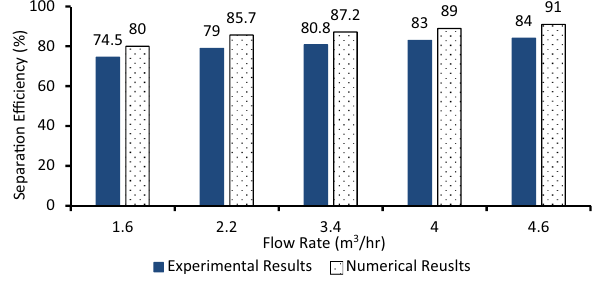
Fig. 6 Comparison between experimental measurements and CFD prediction of separation efficiency results, of 80:20 water-to-oil ratio at 80 °C, for different flow rates